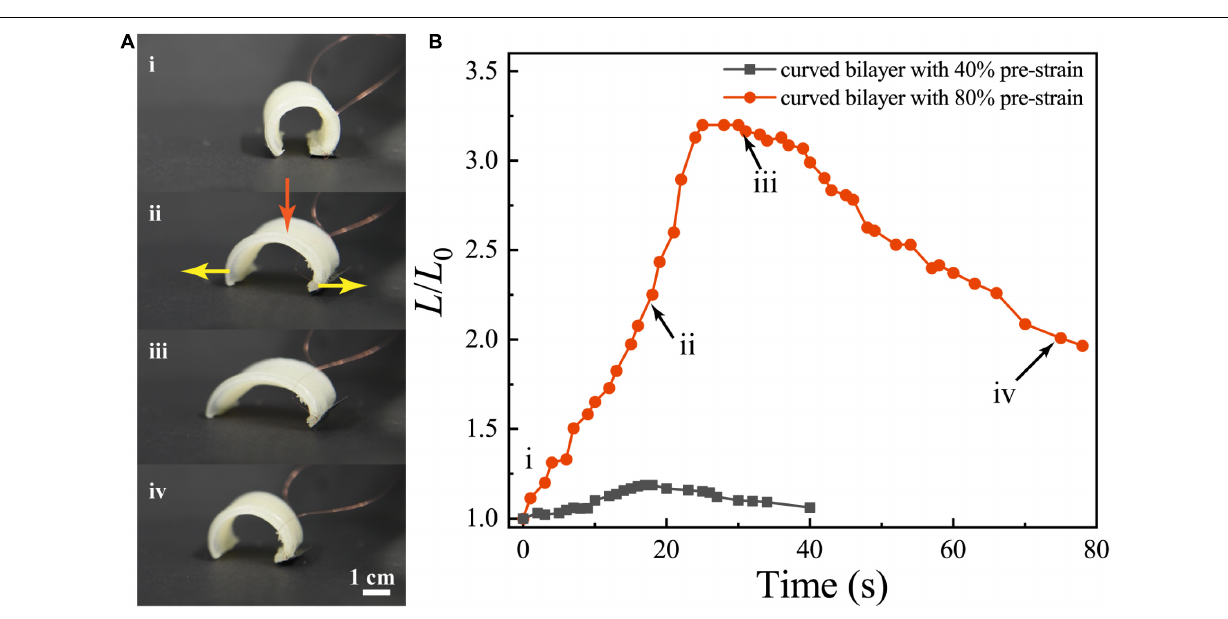
the locomotion of the crawler. To break the symmetry of the crawler and realize effective locomotion, two different flat sheets are attached to the end of the bilayer as shown in reference